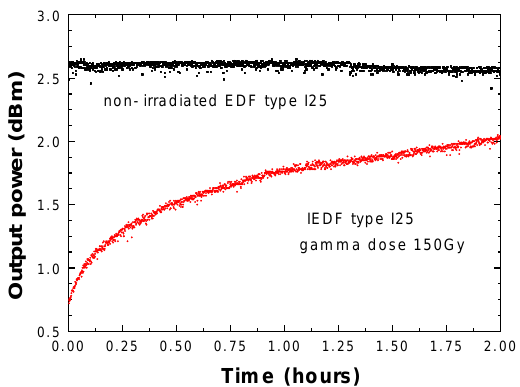
Figure 4. Output power variation over time when using 5 m of a non-irradiated EDF I25 (black) or an IEDF I25 with 150 Gy (red).